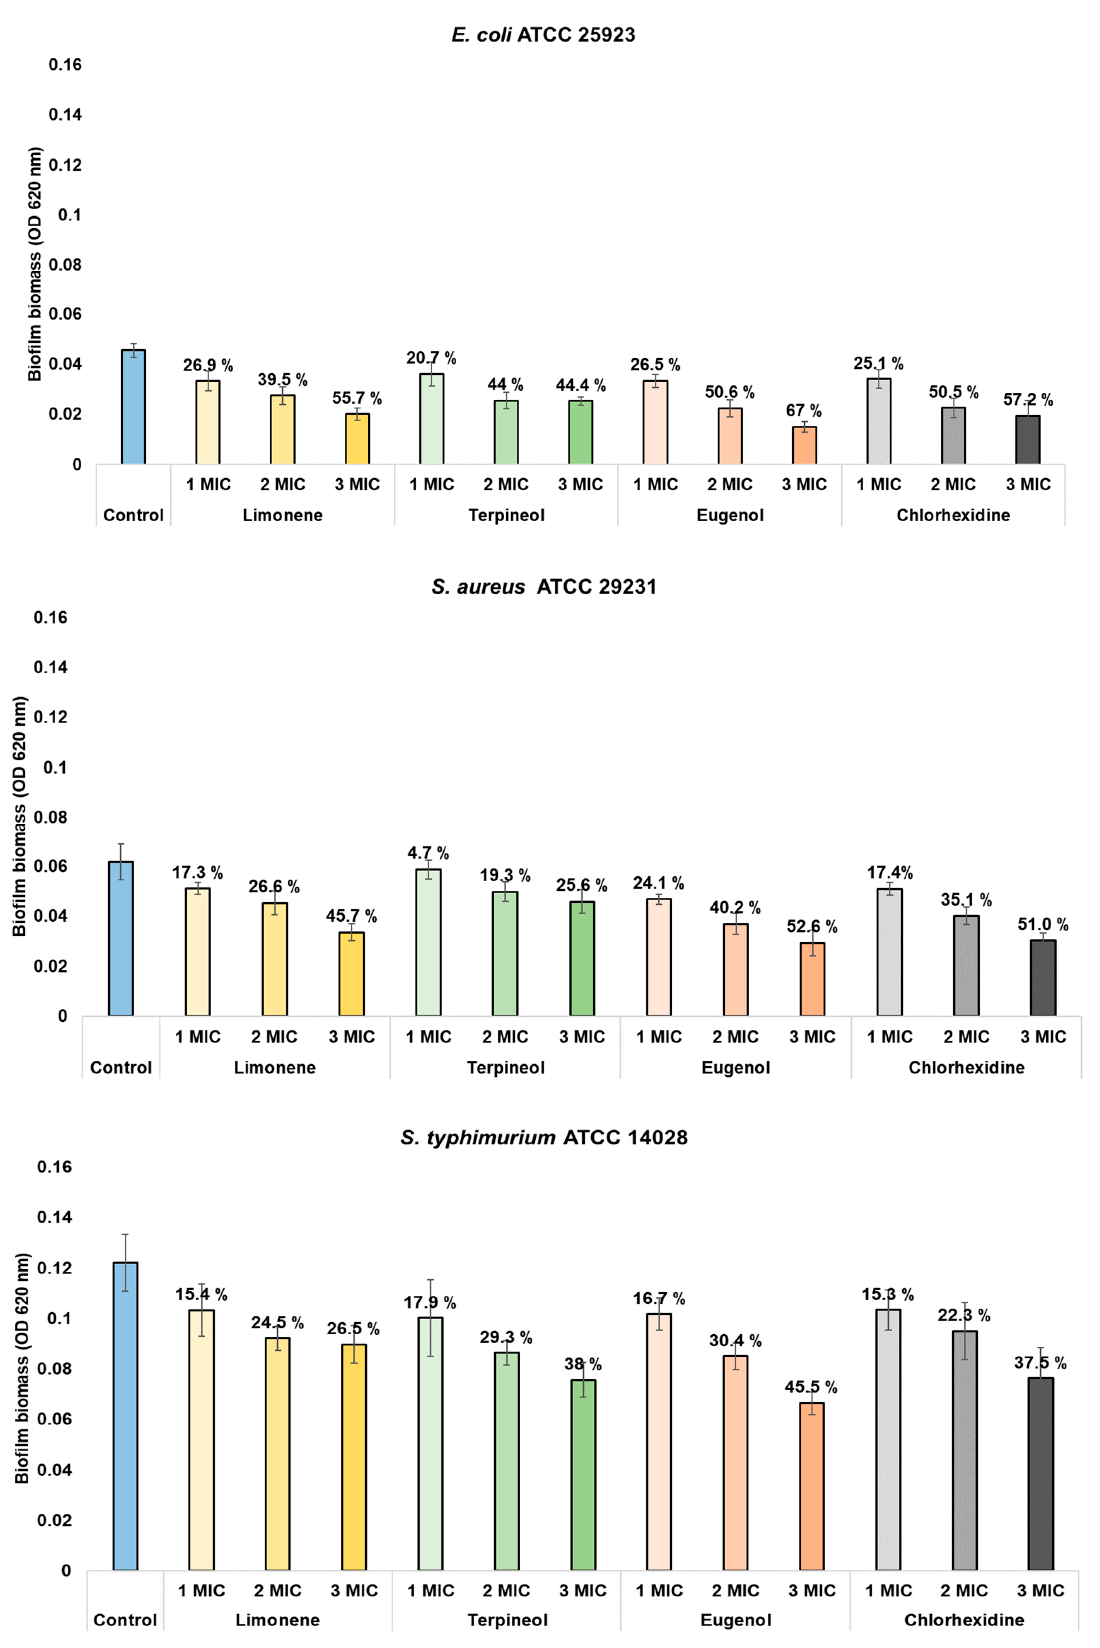
Figure 2. Biofilm biomass (OD620 nm and %) of E. coli, S. aureus and S. typhimurium after exposure to 1 MIC, 2 MIC and 3 MIC limonene, terpineol eugenol and chlorhexidine.